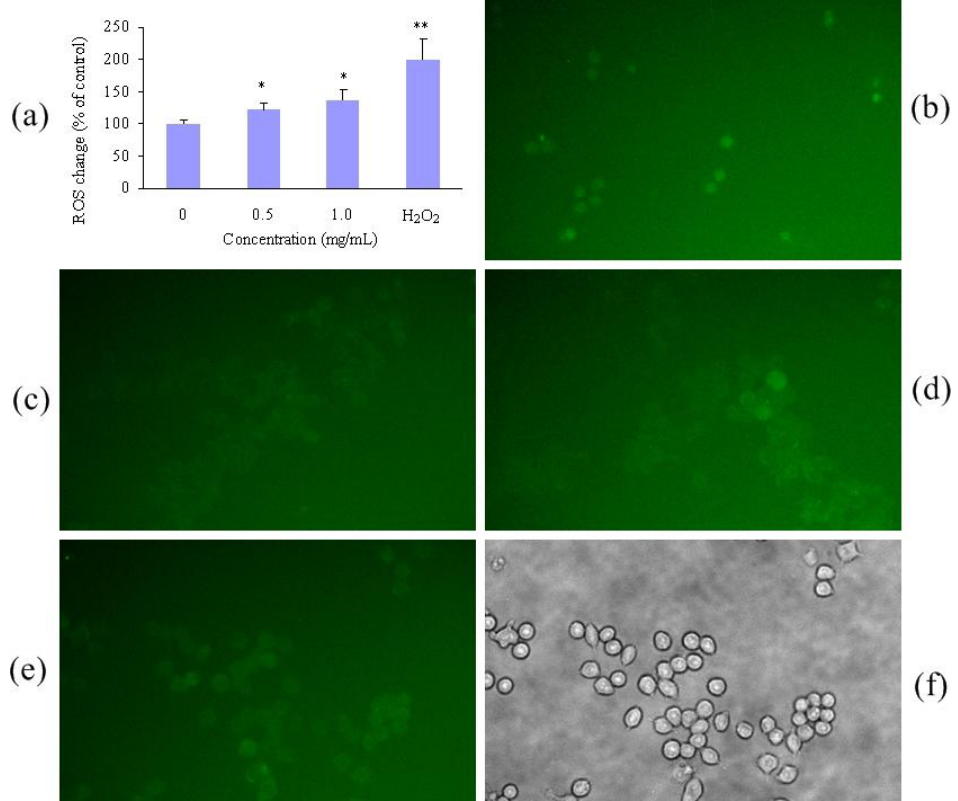
Figure 2. Effects of PEG-PCL-PEG micelle on the level of ROS in RAW264.7 cells. ( a ) Cells were treated with micellar solution (0, 0.5 and 1.0 mg/mL) and H 24 h, incubated with 20 μM dichlorofluorescin-diacetate (DCFH-DA) for 30 min, and then washed with phosphate-buffered saline. The cells were lysed with 0.5% Triton in PBS and the fluorescence of aliquot was measured. The bars marked with * and ** ( p < 0.01) showed statistically significant differences from the treated group compared with control and H solution (1 mM), respectively. ( b−e ) Cells were observed with a fluorescent microscope (200×): H O solution ( b ); Control ( c ), 0.5 mg/mL ( d ) and 1.0 mg ( e ). ( f ) The morphology 2 2 of cells treated with 1.0 mg/mL micelles after 24